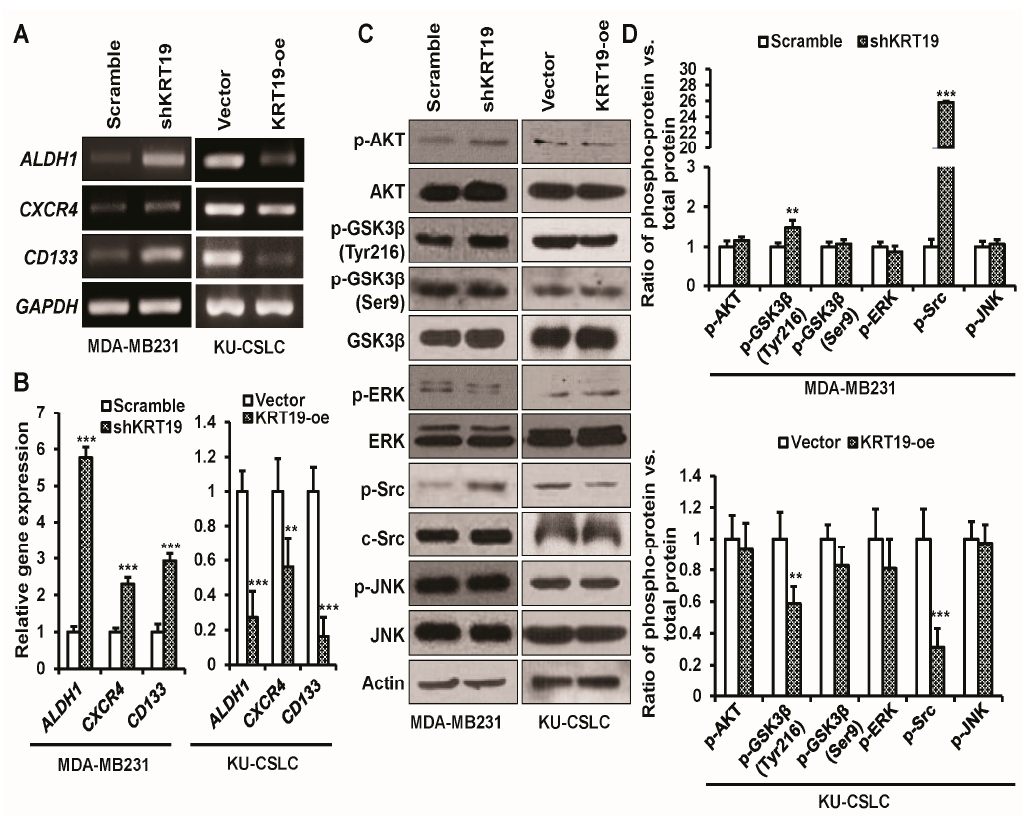
Figure 6. KRT19 regulates cancer stem cell reprogramming through p-GSK3 β (Tyr216) and p-Src signaling pathway. ( A , B ) mRNA expression levels of cancer stem cell markers ( ALDH1 , CXCR4 , and CD133 ) were analyzed in the indicated cells while using RT-PCR analysis. The specific band intensity was measured using the scanning densitometry program in ImageJ and normalized to that of a housekeeping gene, GAPDH . ** p < 0.01; *** p < 0.001; ( C , D ) Representative WB analysis of the AKT, GSK3 β , ERK, Src, and JNK signaling proteins in indicated cells. The specific band intensity was measured by the scanning densitometry program in ImageJ and normalized to that of a total protein. ** p < 0.01; *** p < 0.001.